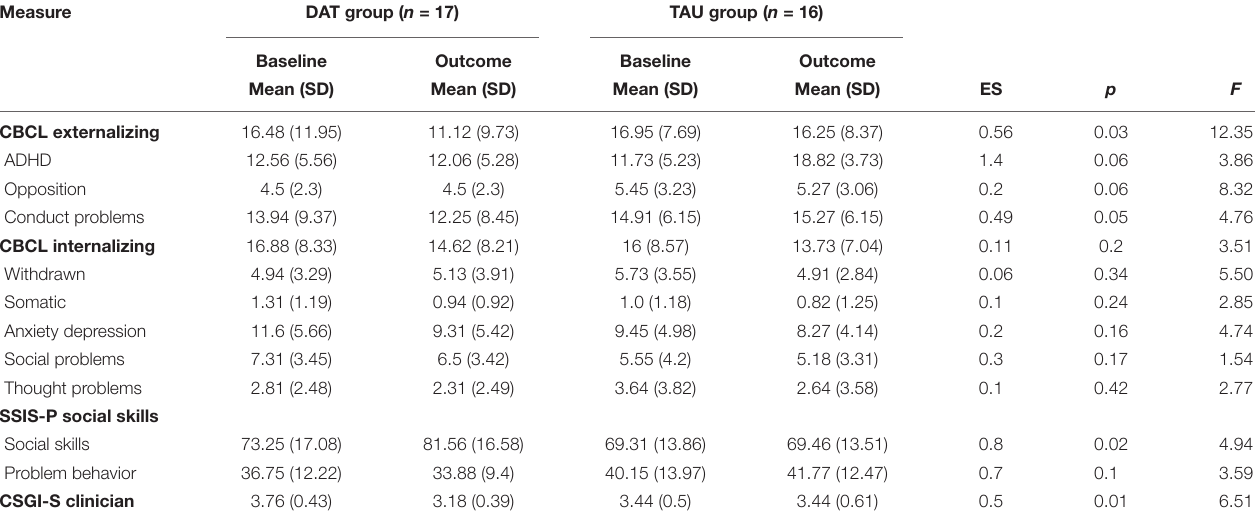
TABLE 2 | Outcome